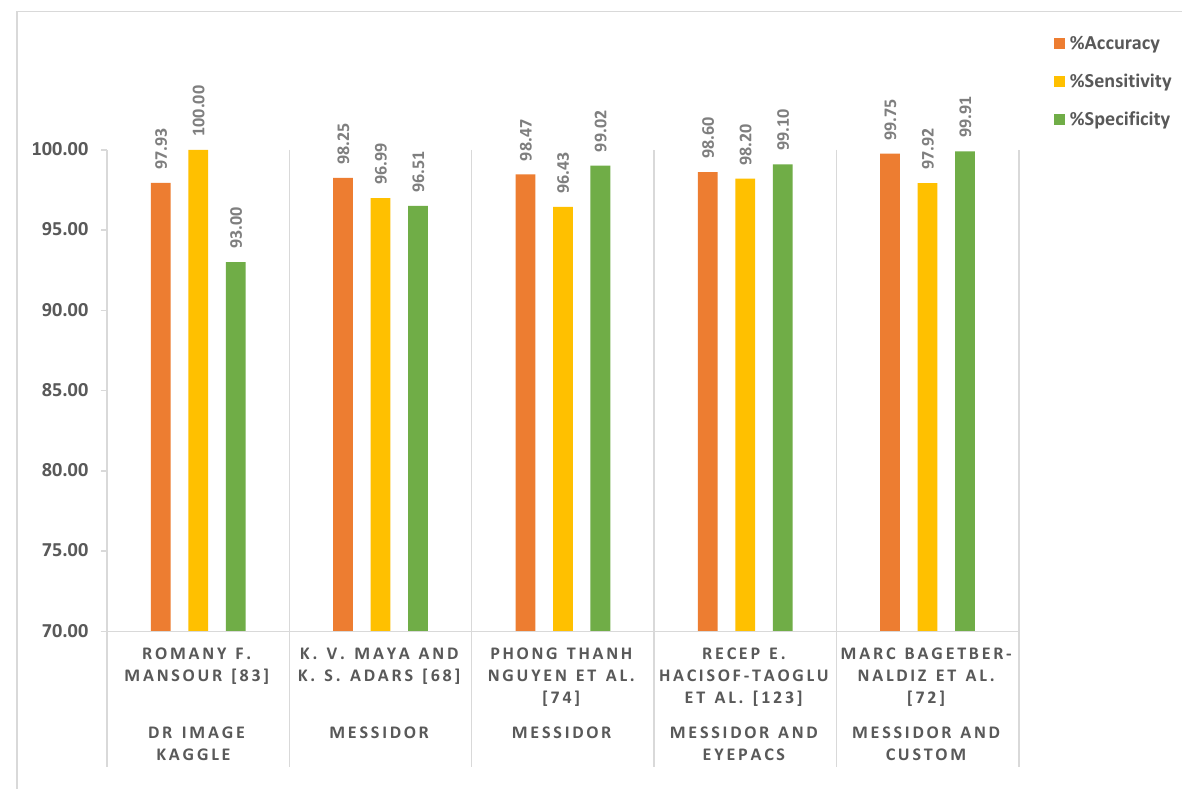
Figure 4. Top 5 publications reporting the best performance for the segmentation.